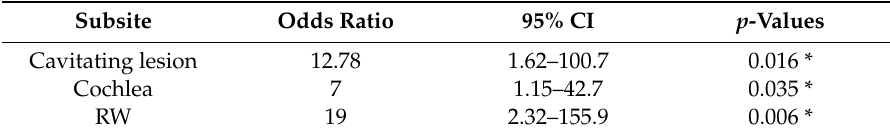
Table 4. Univariate logistic regression analysis to determine subsites predicting surgical